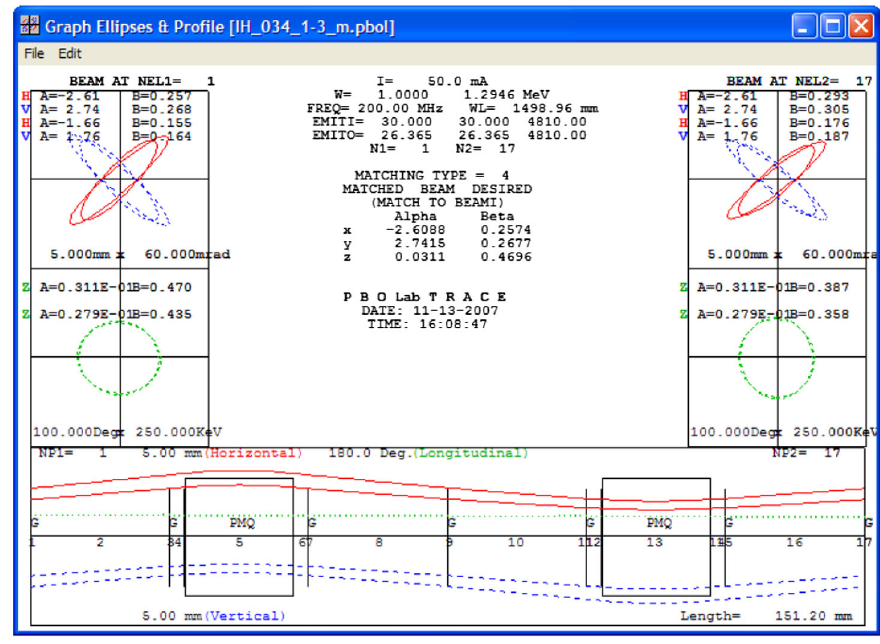
FIG. 2. Beam matching results and envelope traces for one focusing period of IH1-3 structure at (cid:1) ¼ 0 : 034